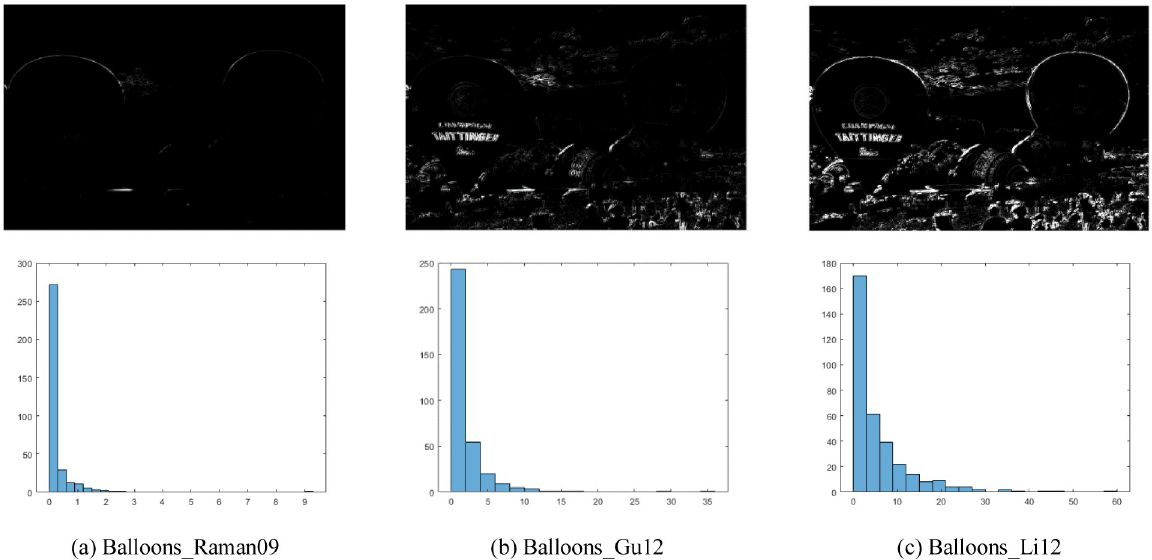
Fig 3. The examples of S NE maps and distribution maps of their corresponding SVD results, where the corresponding MEF images are listed in the first line of Fig 2. The first line represents S NE maps, the second line represents distribution maps. (a) Balloons_Raman09, (b) Balloons_Gu12, (c)